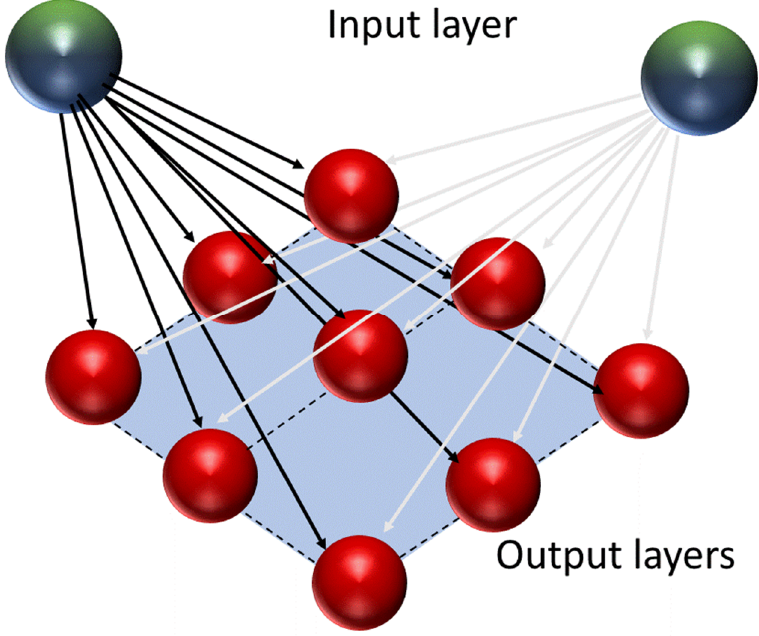
Figure3. SchematicillustrationofthestructureofaSOMwithtwoinputneuronsand3 × Figure 3. Schematic illustration of the structure of a SOM with two input neurons and 3 × 3 Kohonen neurons.